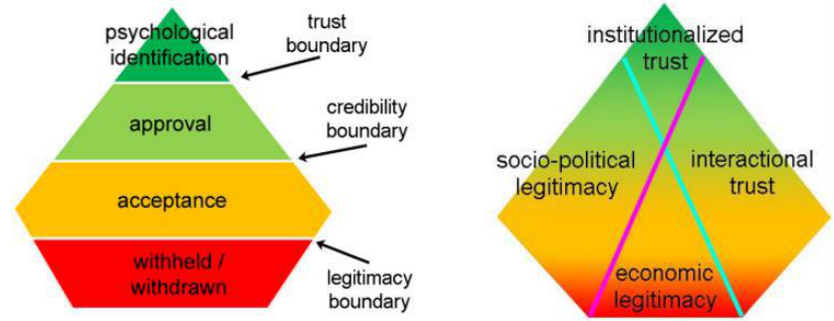
Figure 1. SLO’s pyramidal model, established by Boutilier and Thomson [70].